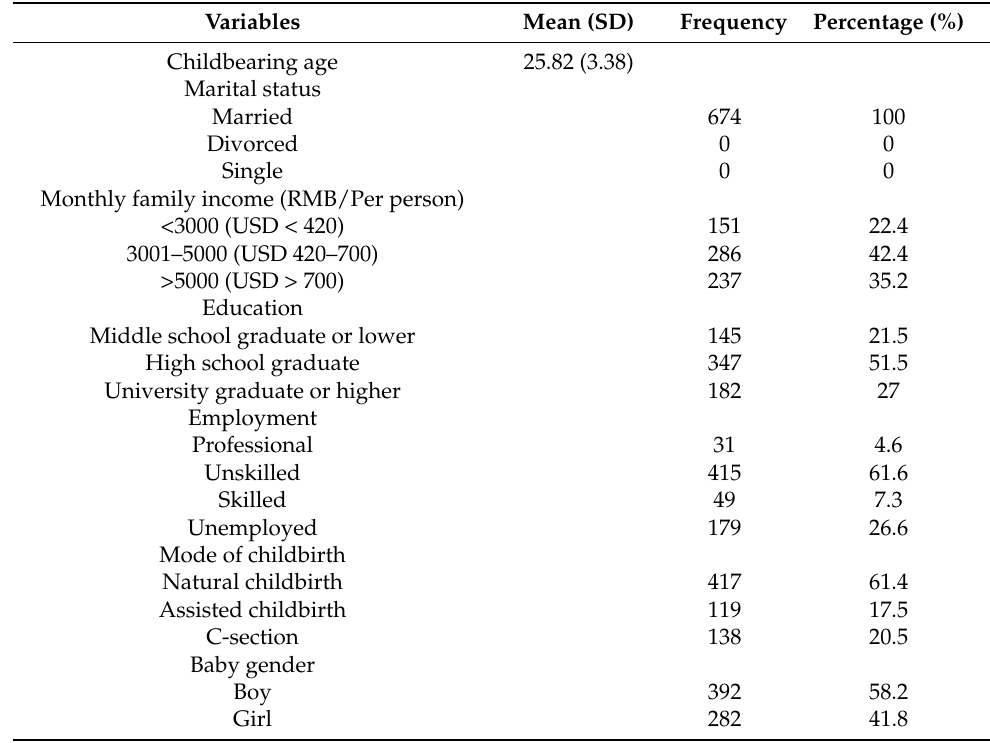
Table 2. Participant profile ( n =